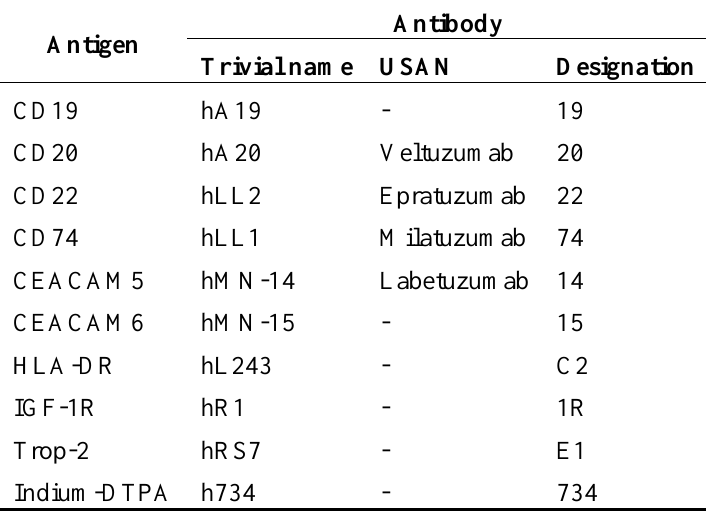
Table 1. Designations of antibodies used in the construction of